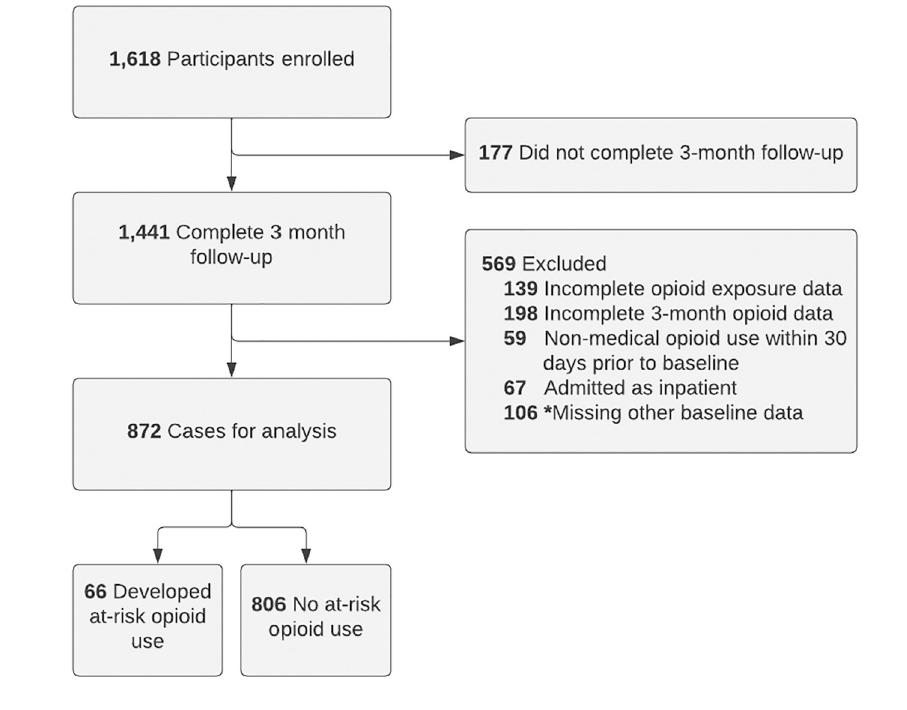
Fig 1. Enrollment, follow-up, and exclusion criteria flow diagram for persons in